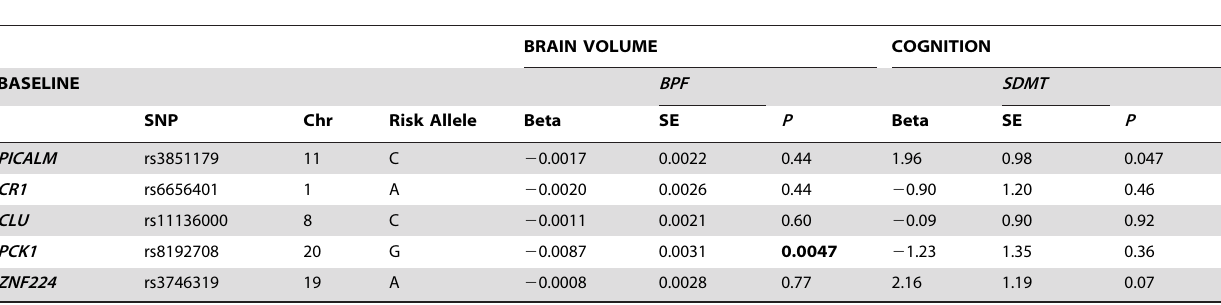
Table 1. Genotype correlation with baseline outcomes at study